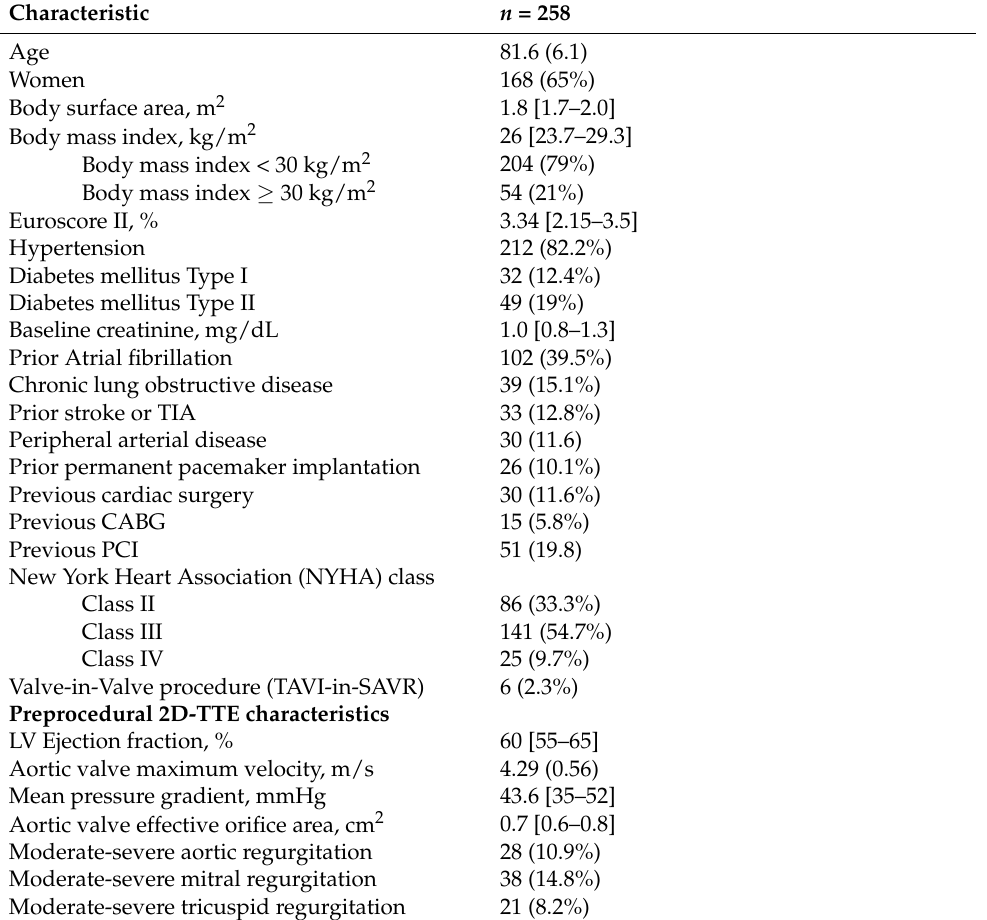
Table 1. Patients’ baseline characteristics, pre-procedural Echocardiography and MDCT